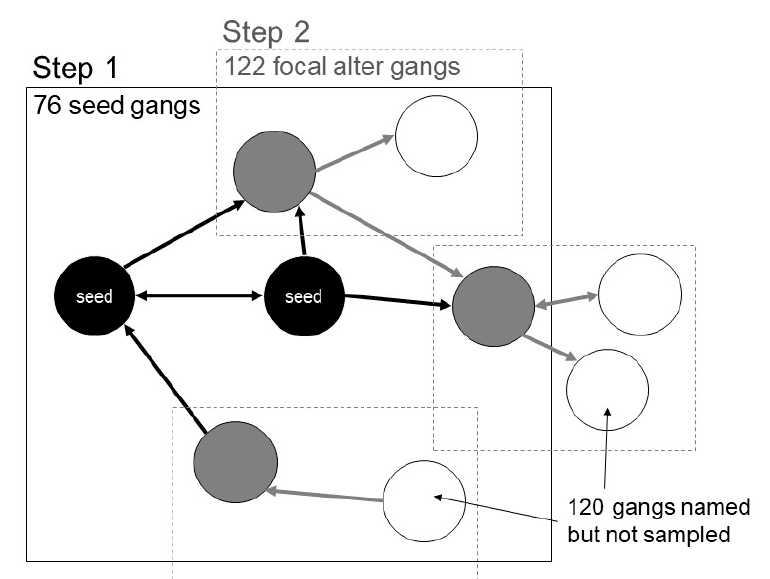
Figure 2. The 2-Step Sampling Process.